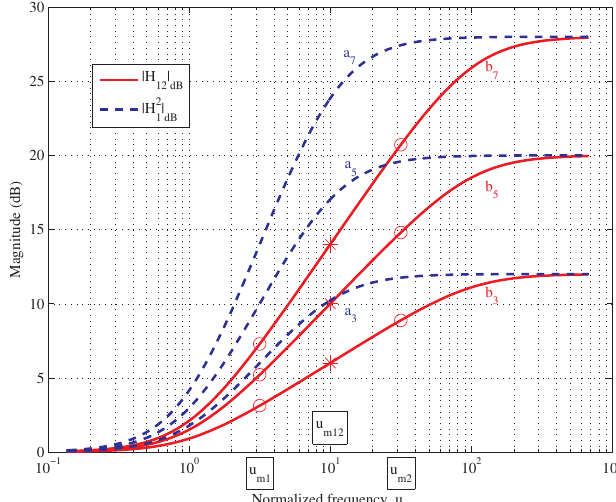
Figure 5. Bode magnitude diagrams of H 2 (dashed lines) and of the Cascaded, Shifted, Fractional-order, 1 LEad Compensators (CS-FLEC) H 12 (solid lines) for ν = ν 1 = ν 2 = 0.3 (curves a 3 , b 3 ), 0.5 (curves a 5 , b 5 ), 0.7 (curves a 7 , b 7